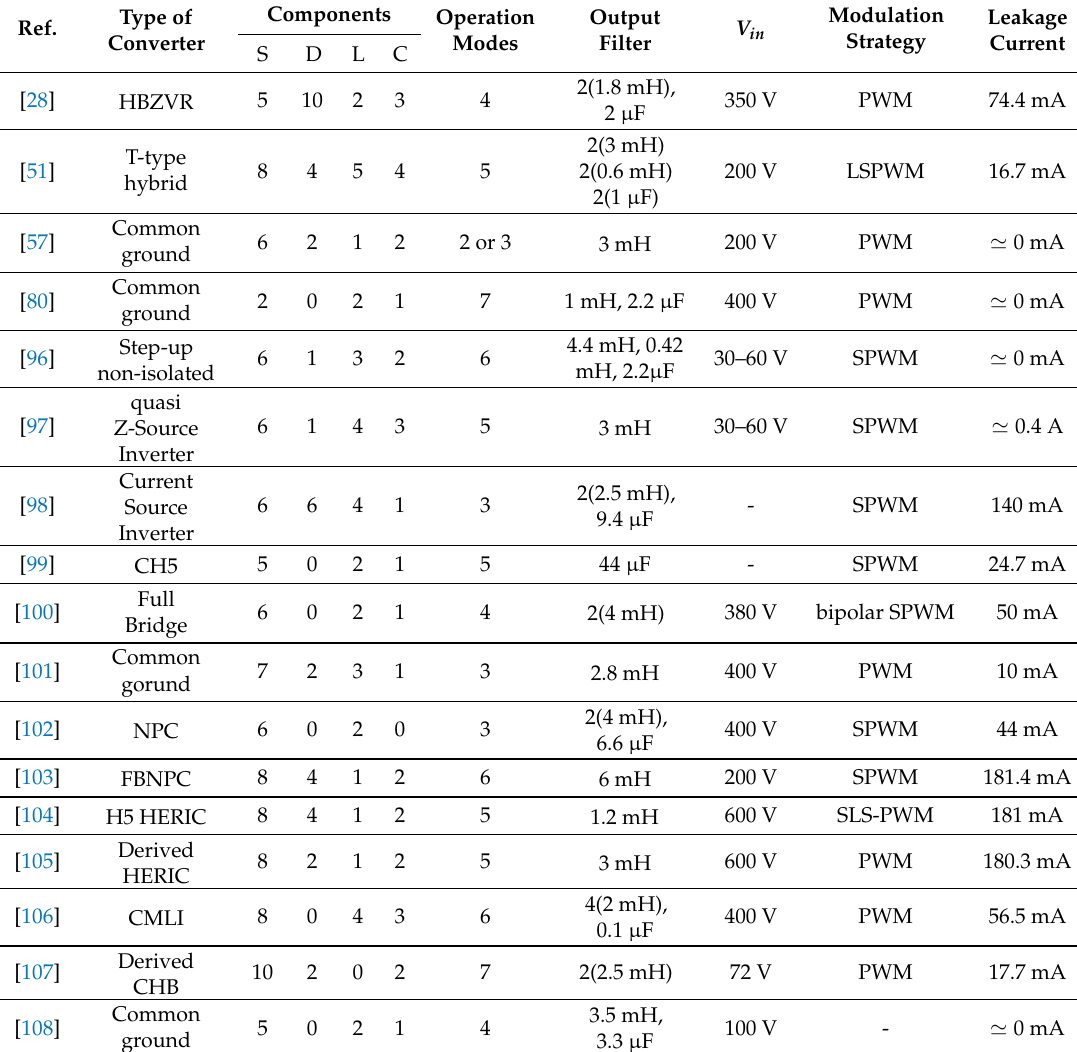
Table 4. Comparision between different